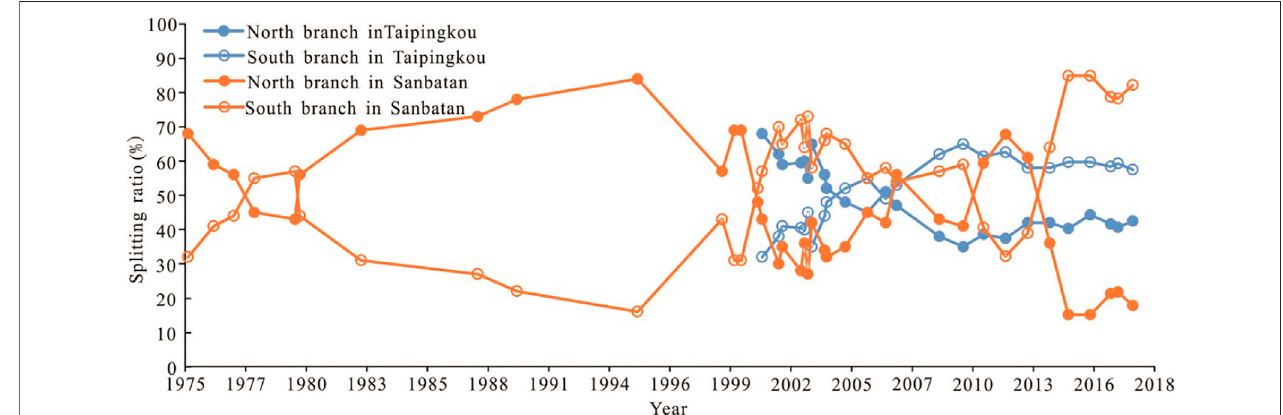
FIGURE 10 | Relationship between the beach evolution and branch diversion ratio in the Taipingkou